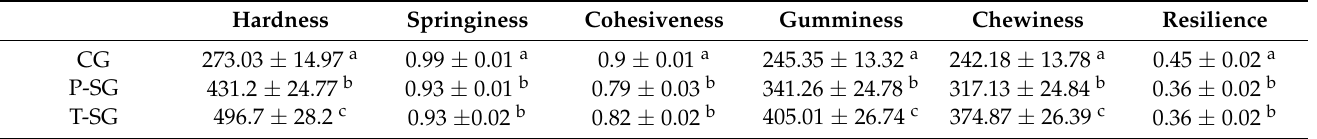
Table 3. Texture profile analysis parameters (TPA) of the three types of gummies (Mean ±